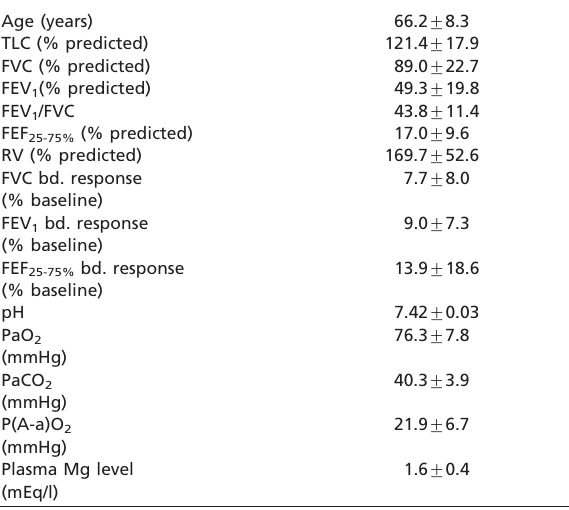
Table 1 - Characteristics of the 20 studied male COPD patients*.